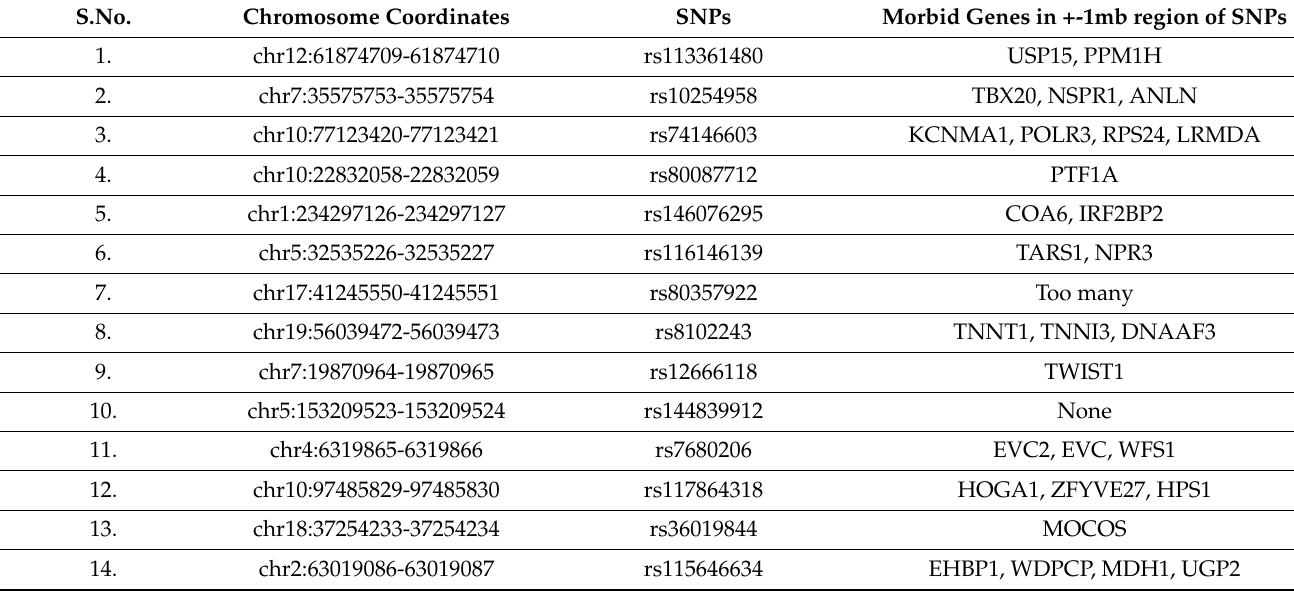
Table 3. List of deciphered morbid genes that are located in the 1 mb region before and after the significant SNPs.